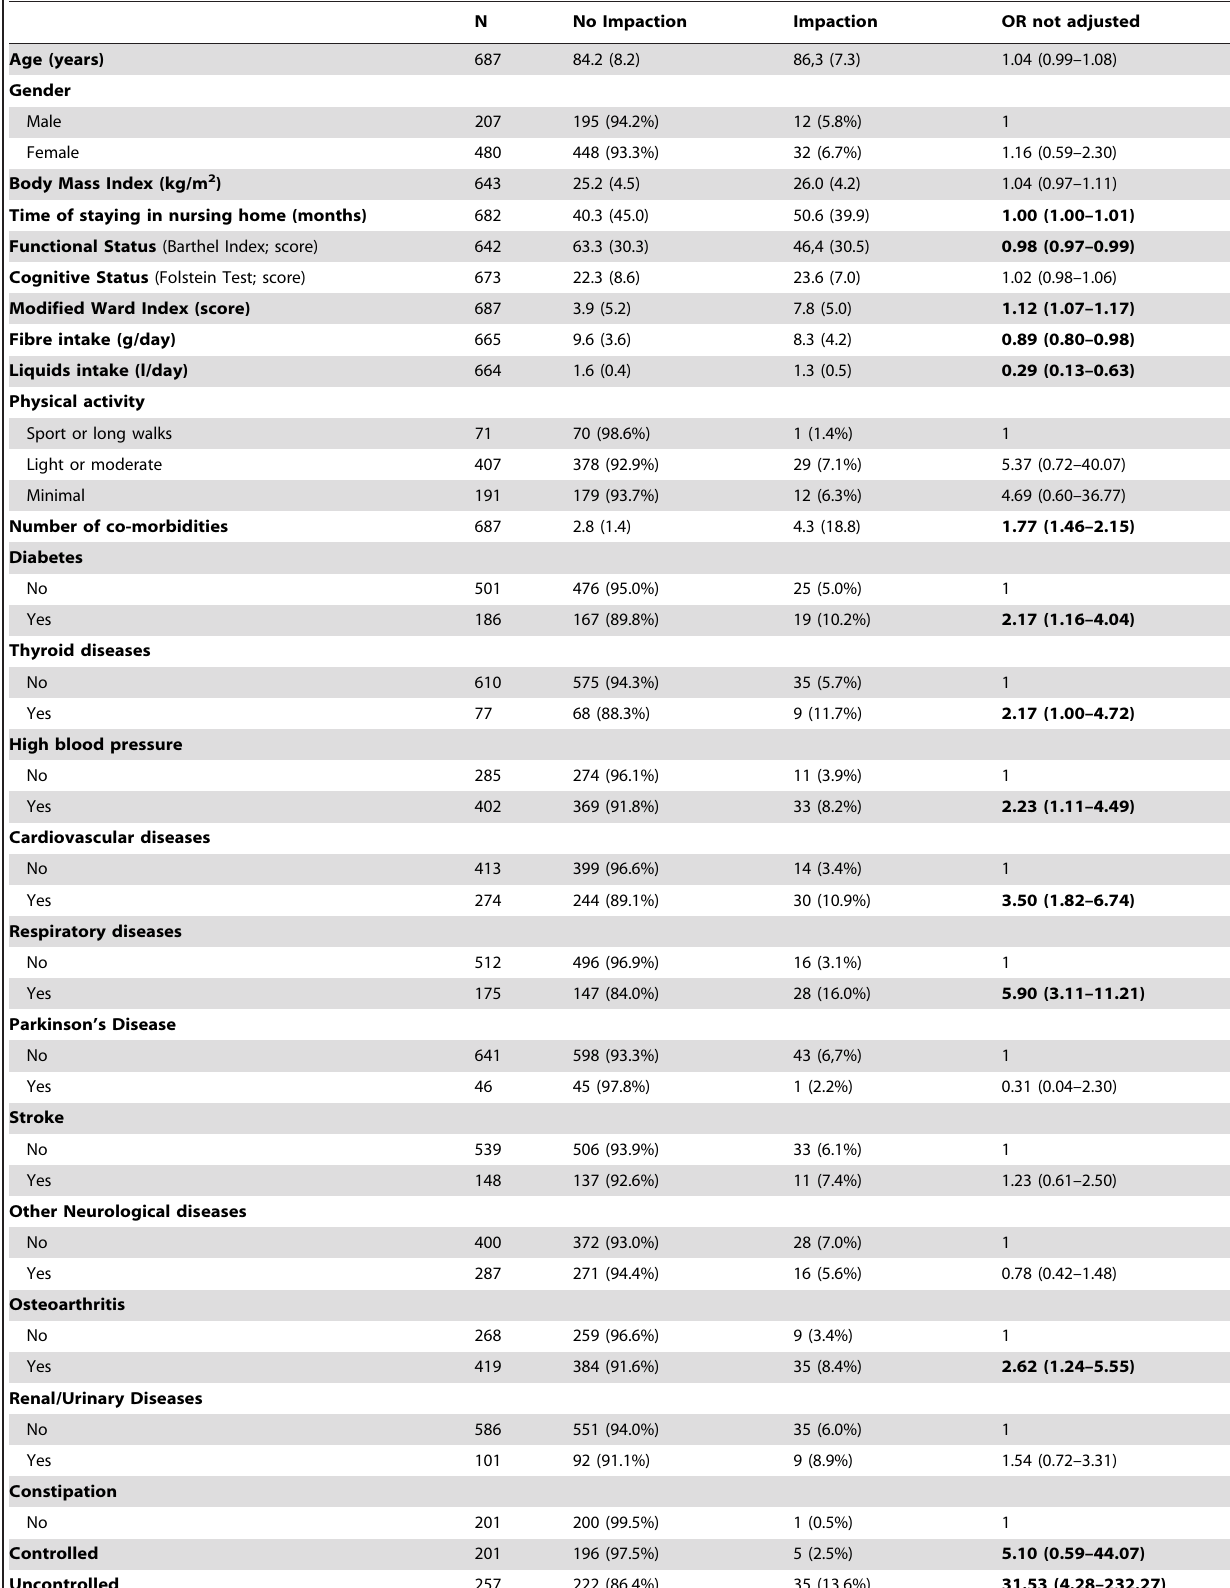
Table 5. Factors associated to Fecal Impaction in rectal